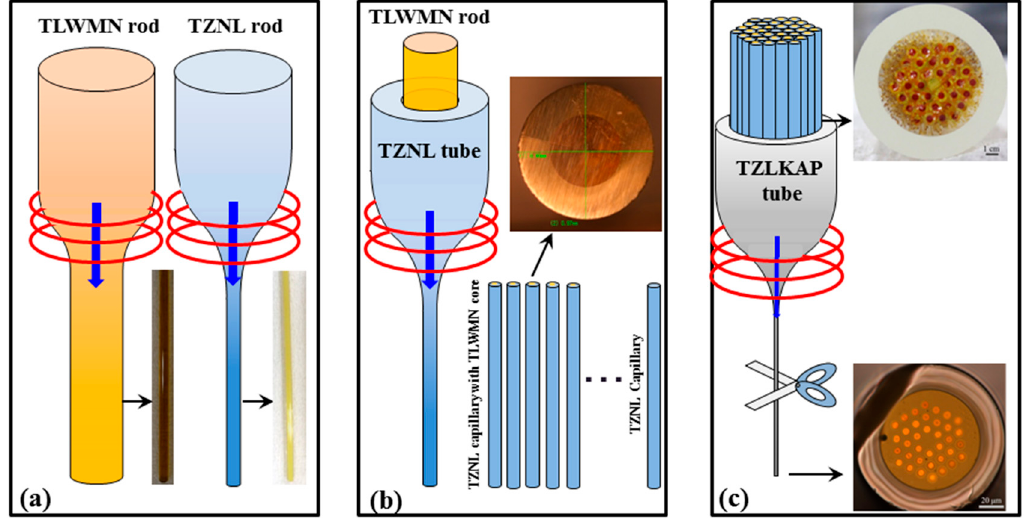
Figure 3. Fabrication process of the all-solid double-clad tellurite PBGF. (a) TLWMN and TZNL capillary. (b) Capillary with TLWMN core. (c) Fabricated the optical fibers.